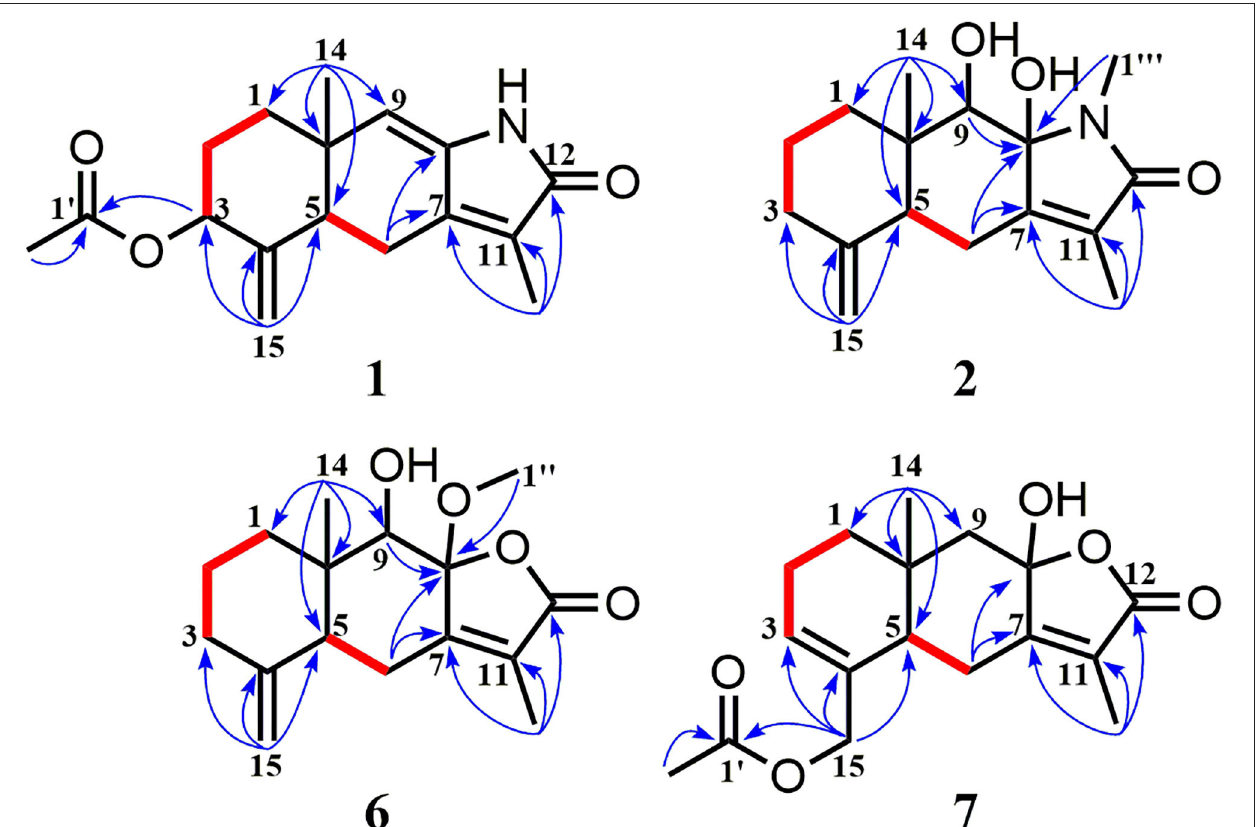
FIGURE 3 | 1 H- 1 H COSY (bold red bonds) and Key HMBC (blue arrows) correlations for new compounds 1 , 2 , 6 , and 7 . NMR data see Table 1 and 13 C NMR data see Table 2 ;